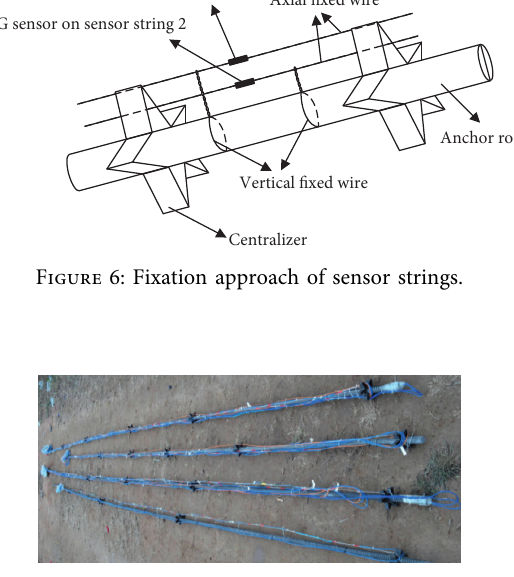
Figure 7: Anchor rods after sensor